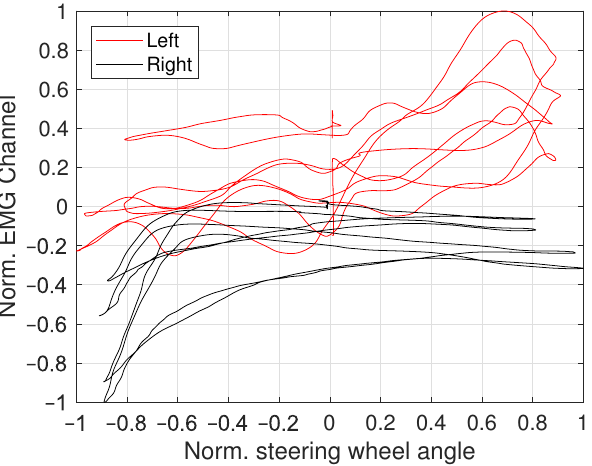
Figure 14. Normalized muscle activity over normalized steering wheel